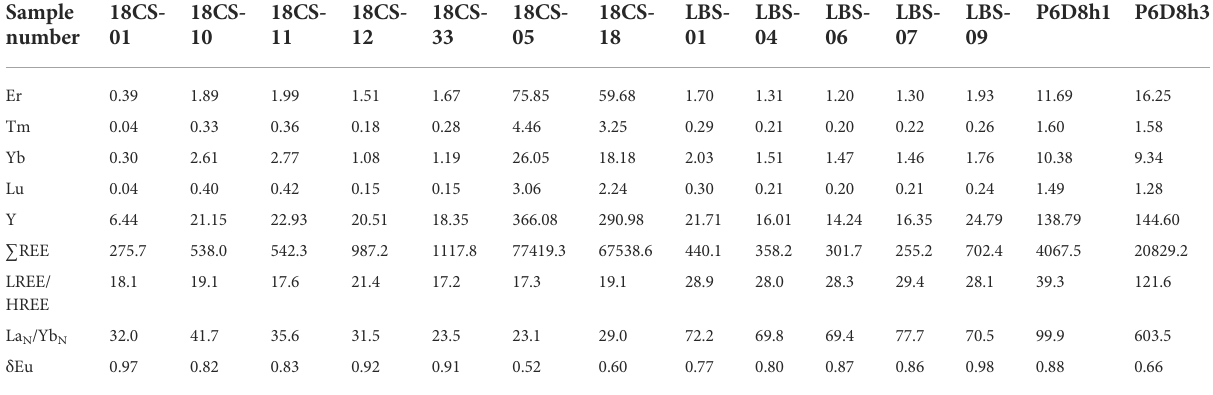
listed in Table 2. The Chishan quartz syenite samples have SiO 2